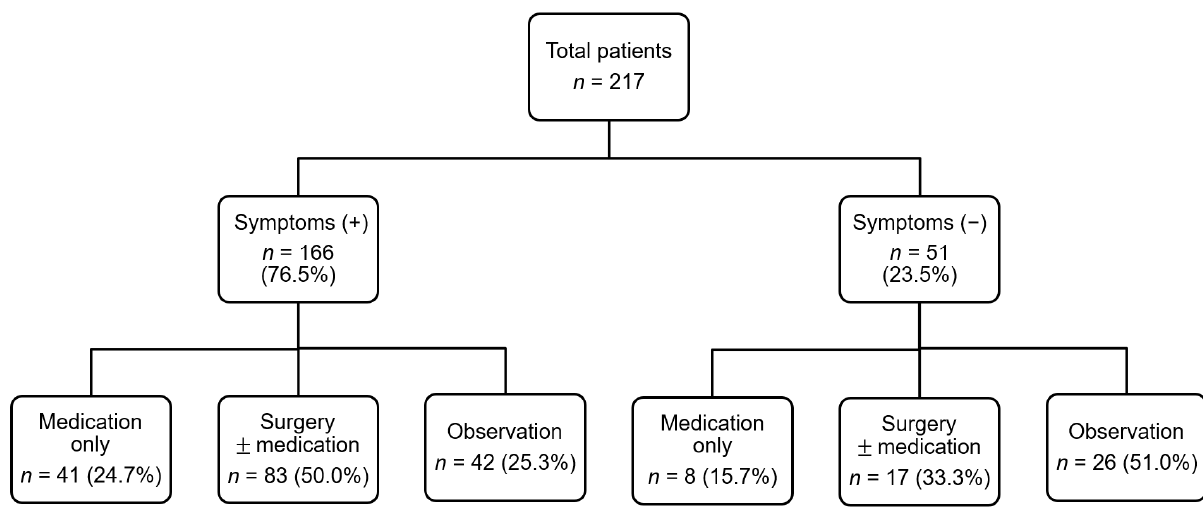
Figure 1. Clinical course of the study participants.